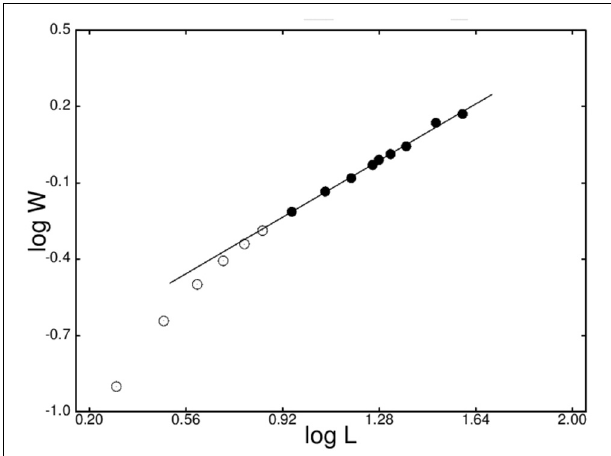
FIGURE 3 | Logarithmic plot, showing the roughness, W , as a function of the system size, L , for disorder D = 2. Black circles denote those points to which the straight line, with slope ζ = 0 . 62(2), has been fitted. The largest errors on the points are approximately the size of the points.